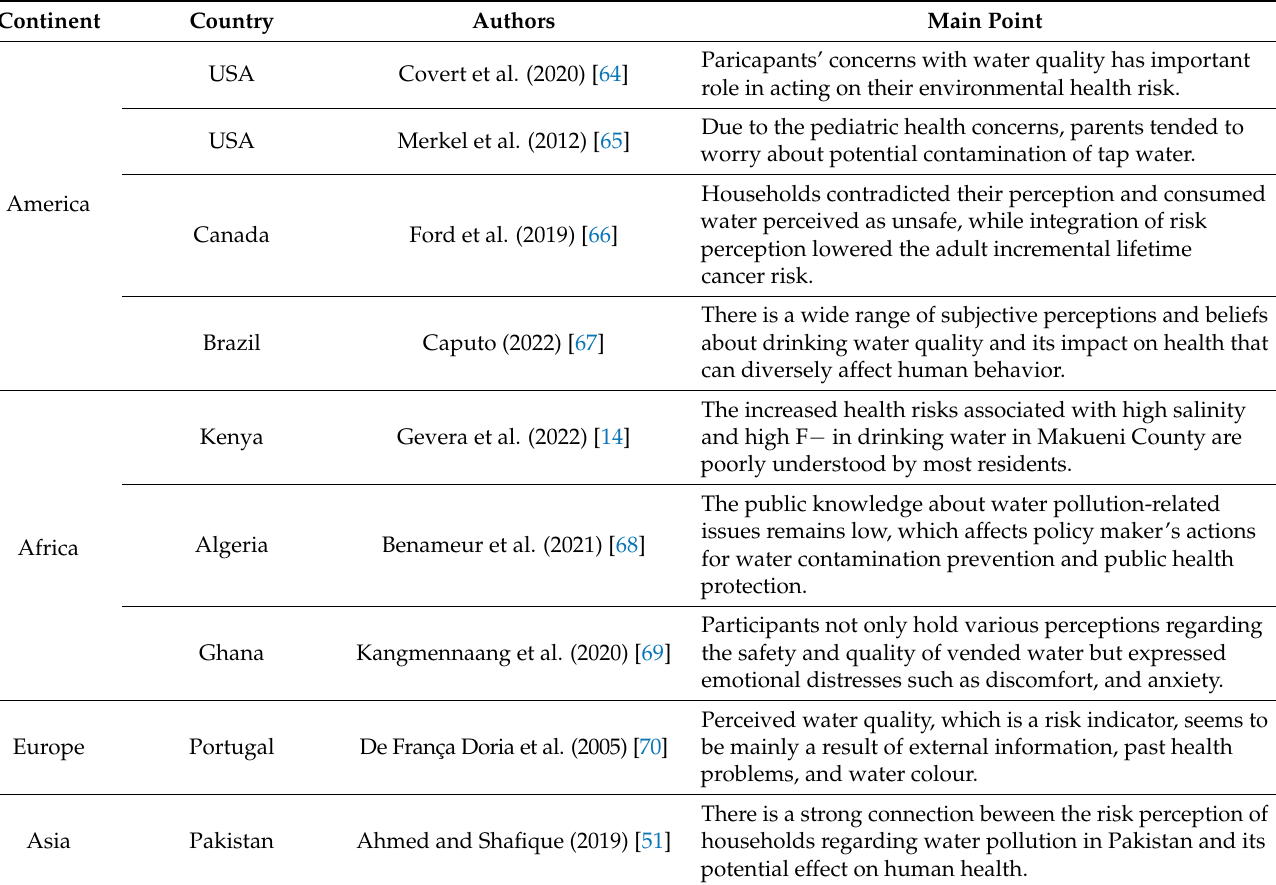
Table 5. Similar studies in other countries under a comparative and global